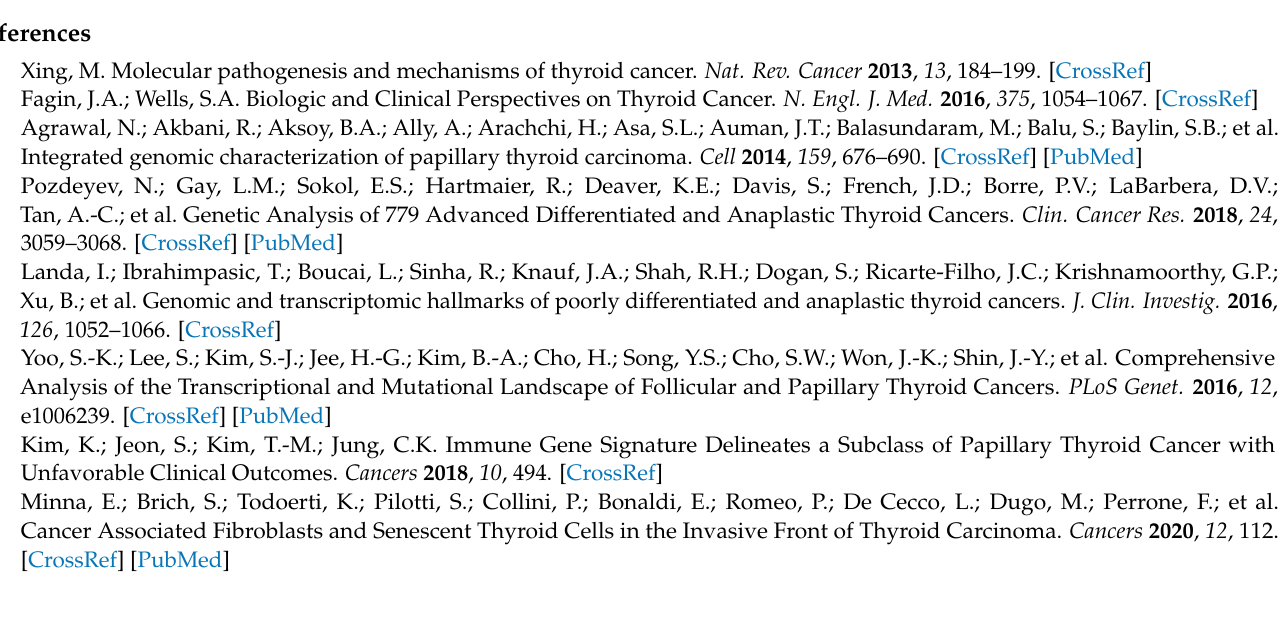
Figure S2: Gene set enrichment analysis with Hallmarks gene set collection in BCPAP cells treated with BRAF inhibitors; Figure S3: GSEA on Hallmark KRAS signaling gene sets in BCPAP cells treated with BRAF inhibitors; Figure S4: Unsupervised analysis using the BRAF-RAS signaling gene signature in BCPAP cells and in thyroid cancer tissues; Figure S5: Alternative MAPK pathway activation upon BRAF inhibitors treatment in 8505C and K1 cell lines; Table S1: Characterization of the thyroid cancer derived cell lines used in the present study; Table S2: Lists of genes included in the TCGA-derived gene signature related to thyroid